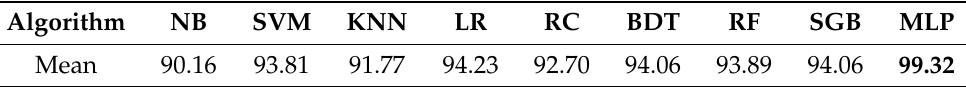
Table 6. Comparison with machine learning algorithms.